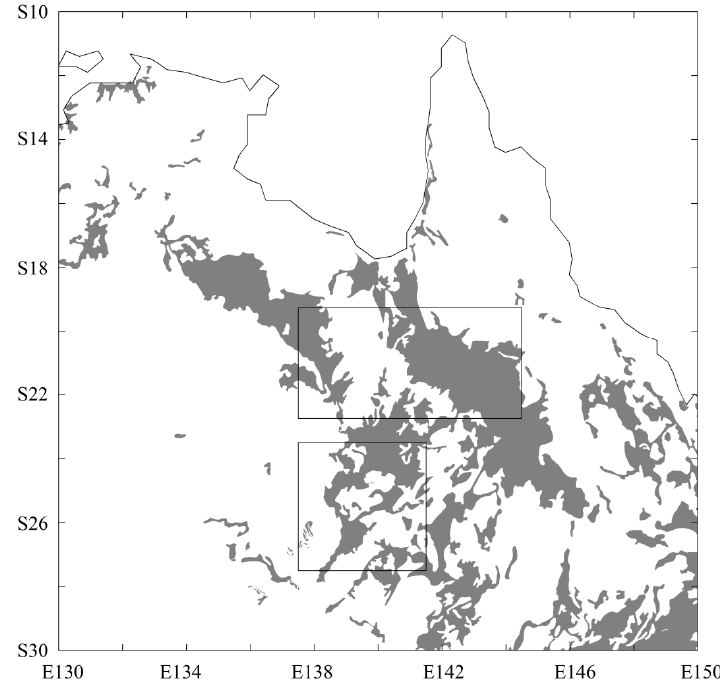
Figure 7. Location of vertisols for the study region based on Harmonized World Soil Database. Vertisols cover 50.2% and 37.3% of the REC and SQU sub-regions, respectively. Four of the five selected land surface models underestimated the memory length of soil moisture,